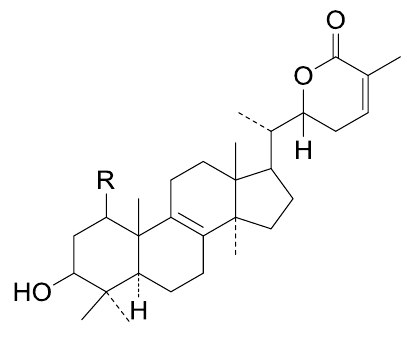
Figure 26. Structures of compounds 267 – 268